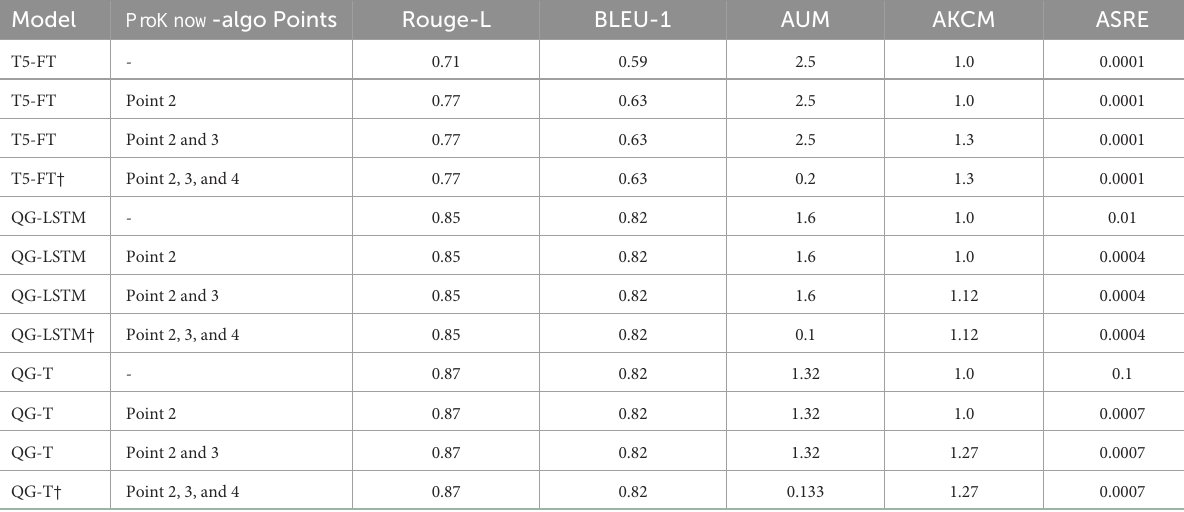
TABLE 6 Ablation study on the QG-T, QG-LSTM, and T5 models.